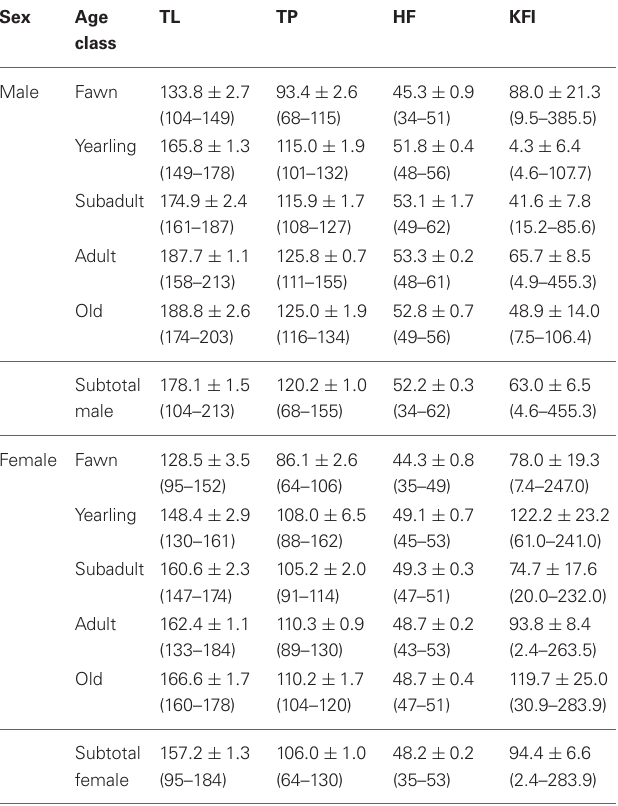
Table 1 | Average values, associated standard error and range (within brackets) of host individual variables [total length (TL; cms), thoracic perimeter (TP; cms), hind foot length (HF; cms), and kidney fat index (KFI; %)] throughout sex and age class of studied deer.